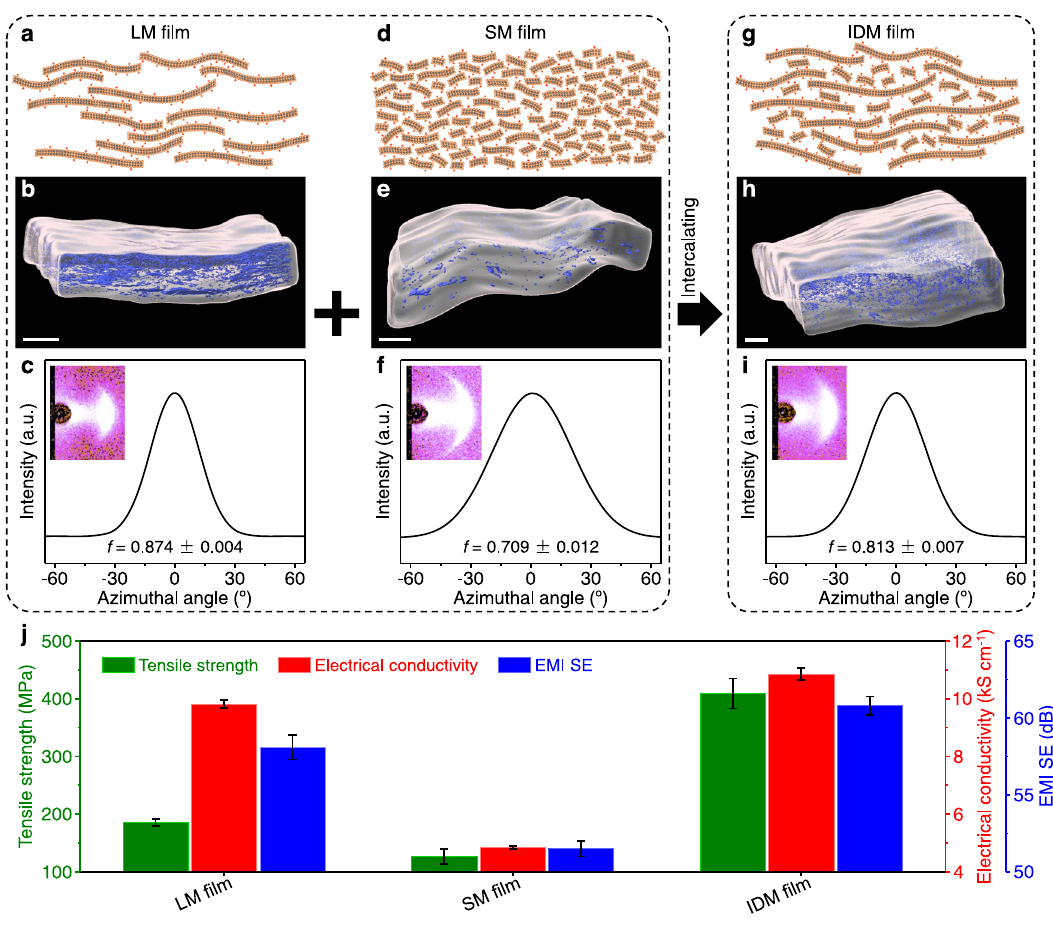
Fig. 2 | Comparison of structure and properties of LM, SM, and IDM fi lms. a – i Structural models, 3D-reconstructed void microstructure by FIB/SEMT, and WAXS patterns for an incident Cu-K α X-ray beam parallel to the fi lm plane and correspondingazimuthalscanpro fi lesforthe002peakforLM( a – c ),SM( d – f ),and IDM ( g – i ) fi lms. The fl ake alignment of LM, SM, and IDM fi lms is 0.874±0.004,